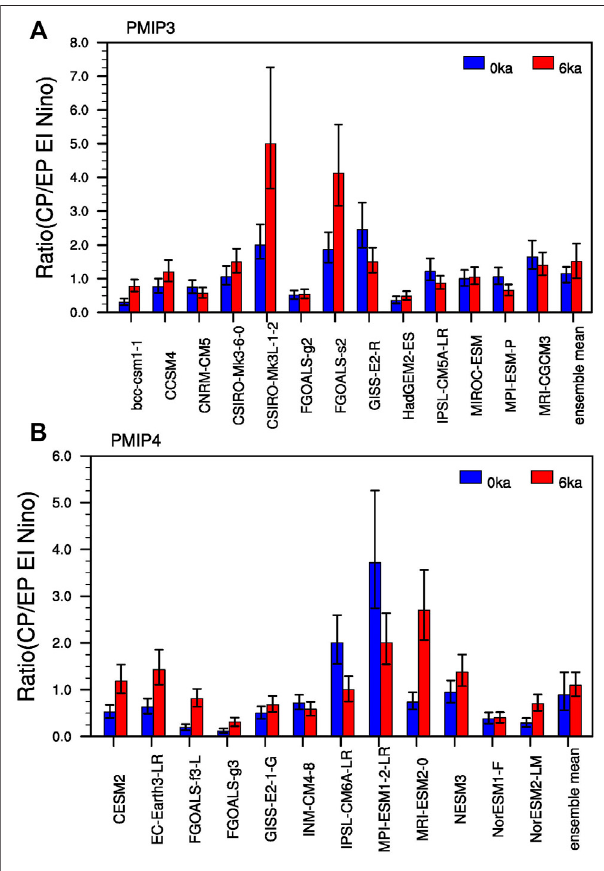
FIGURE12| Rates ofdifferenttypes ofElNiñoobtained from (A) PMIP3 and (B) PMIP4 models. Blue and red bars represent PI and MH simulations, respectively. The error bars represent the upper and lower limits of varying range in the occurrence ratio at the 95% con fi dence level by using the bootstrap method.